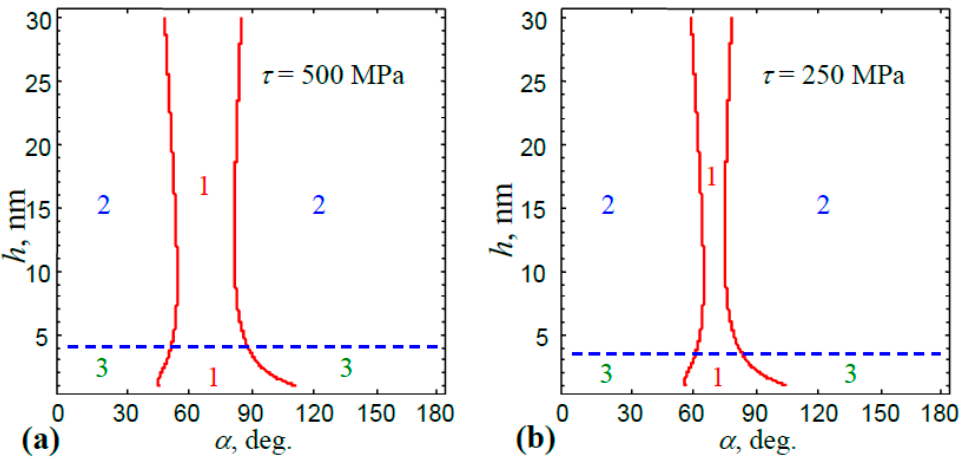
Figure 3. Map of parameters ( h , α ) which was divided into regions of energetically favorable or unfavorable nanocrack formation and / or lattice dislocation emission, for various values of the external shear stress ( a ) τ = 500 MPa and ( b ) τ = 250 MPa.